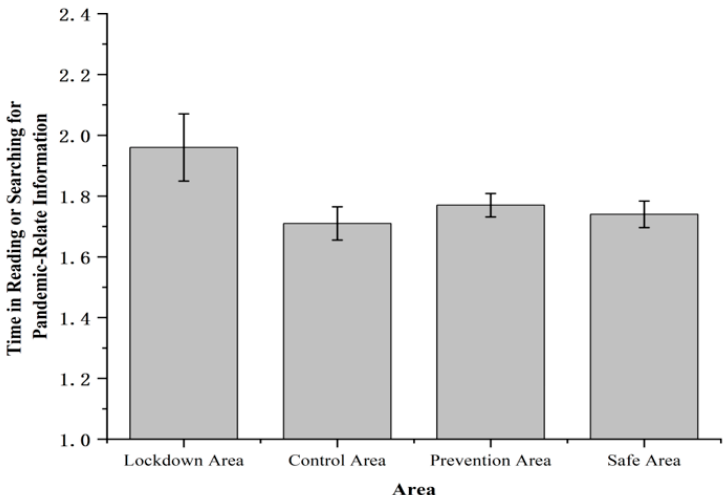
Figure 2. Time in reading or searching for pandemic-related information. Note: The rating of time in reading or searching for pandemic-related information was measured on a 5-point scale (1 = less than 30 min, 2 = 30 to 60 min, 3 = 1 to 3 h, 4 = 3 to 5 h, 5 = more than 5 h). Concerns about the pandemic information were significantly different among four areas, F (3, 1631) = 2.97, p < 0.05, η 2 p = 0.005 (Figure 3). Participants in the control area (3.08 ± 0.03) reported significantly lower concerns about the pandemic compared with that in the prevention area (3.20 ± 0.03), p <